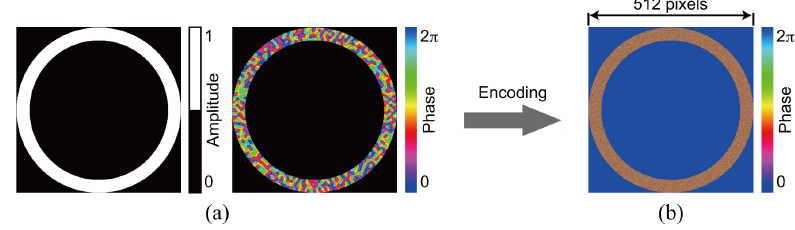
Figure 9. Reference beam for recording data page 2. ( a ) complex amplitude distribution and ( b ) phase hologram.